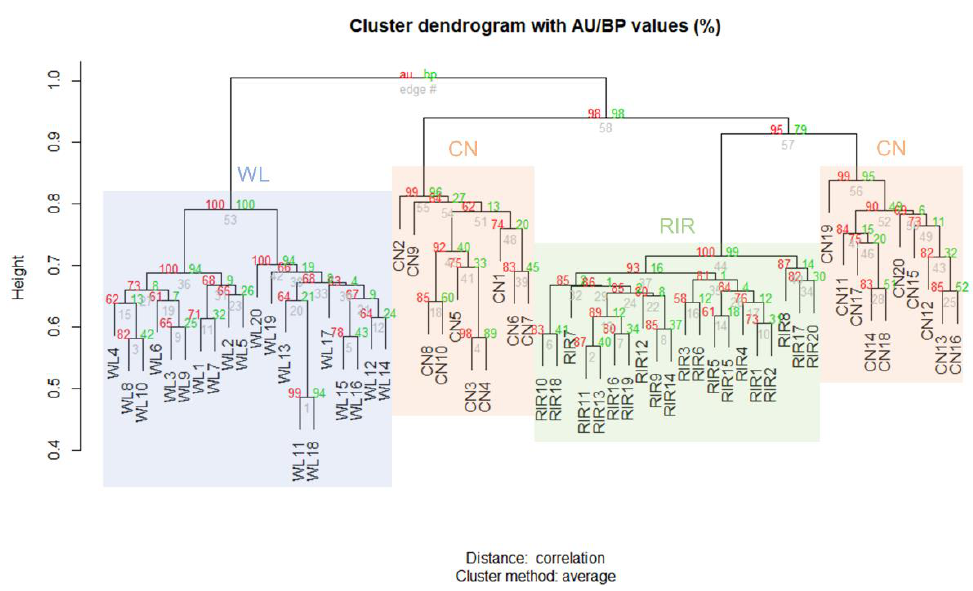
Figure 2. Hierarchical clustering analysis according to the presence or absence of CNVR.